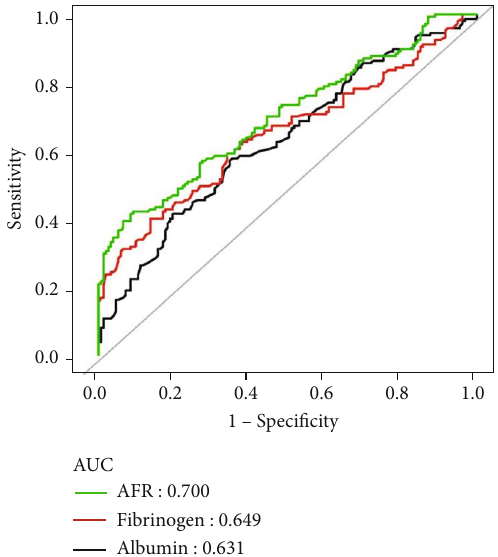
Figure 2: The ROC curve analysis of albumin, fi brinogen, and AFR for the prognostic value of 28-day mortality in patients with sepsis.